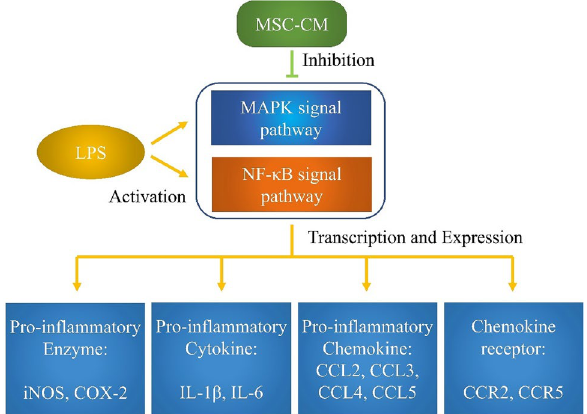
Figure 4. MSC-CM suppressed the gene expression of pro-inflammatory factors via the MAPK and NF-κB signaling pathways to inhibit inflammation. MSC-CM, mesenchymal stem cell conditioned media; MAPK, mitogen-activated protein kinase; SAPK/JNK, stress-activated protein kinase/Jun-amino-terminal kinase; ERK, extracellular signal-regulated kinase; NF-κB, nuclear factor kappa-B; iNOS, inducible nitric oxide; COX-2, cyclooxygenase-2; IL1β, interleukin-1β; CCL, C–C motif ligand; CCR, C–C motif receptor; LPS,